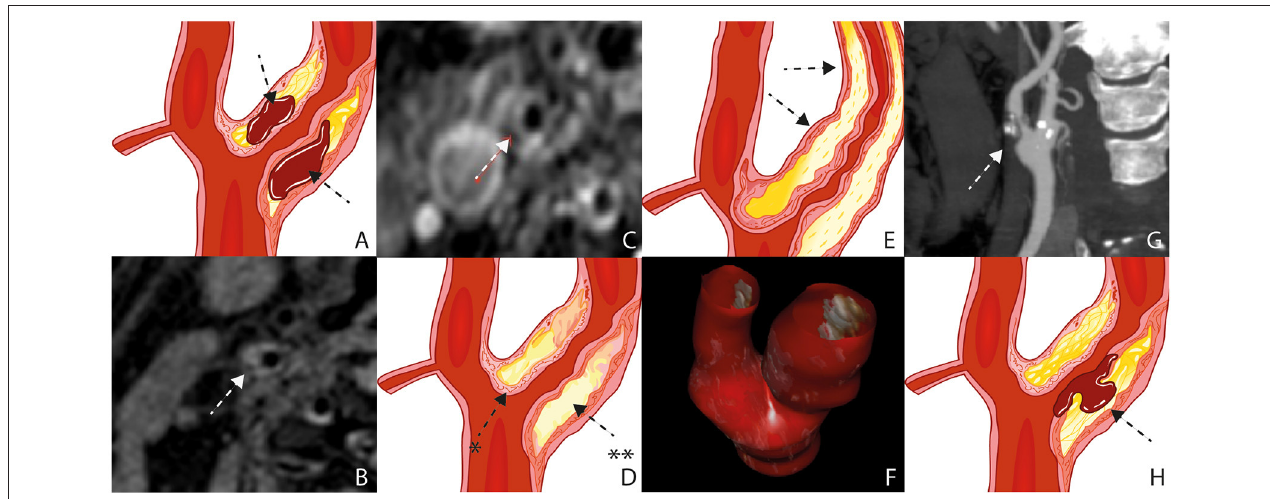
FIGURE 1 | Plaque Characteristics. Schematic figure illustrating intraplaque hemorrhage (A) , MRI on a 3 Tesla scanner (B) ; white arrow), The axial T1 turbo spin-echo with fat saturation image post gadolinium shows a pronounced LRNC covered by an intact fibrous cap (C) ; white arrow), Schematic figure illustrating a pronounced LRNC ( ** ) covered by an intact fibrous cap ( * ) (D) , Schematic figure illustrating a pronounced bulky plaque (E) ; black arrows), 3D ultrasound volume analysis (F) , surface morphology, image obtained by CT (G) , Schematic figure illustrating plaque rupture with an ulceration (H) ; black arrow). LRNC, lipid-rich necrotic core; MRI, Magnetic Resonance Imaging; CT,Computed